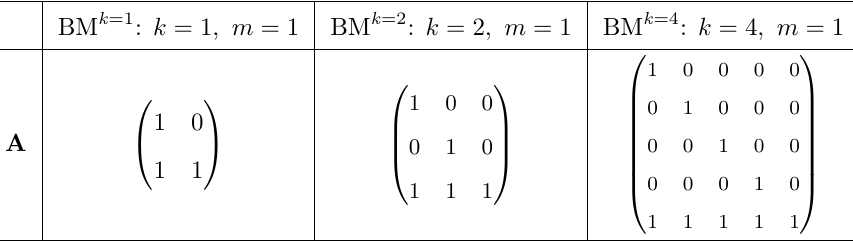
for BM instances in 2 8